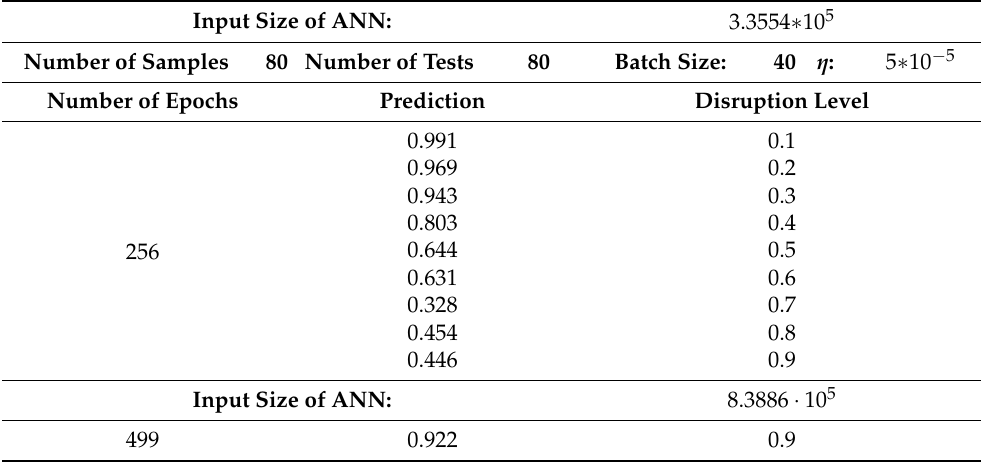
Table 11. Efficiency of signal recognition using the CNN based on a sampled signal in the presence of interference from other